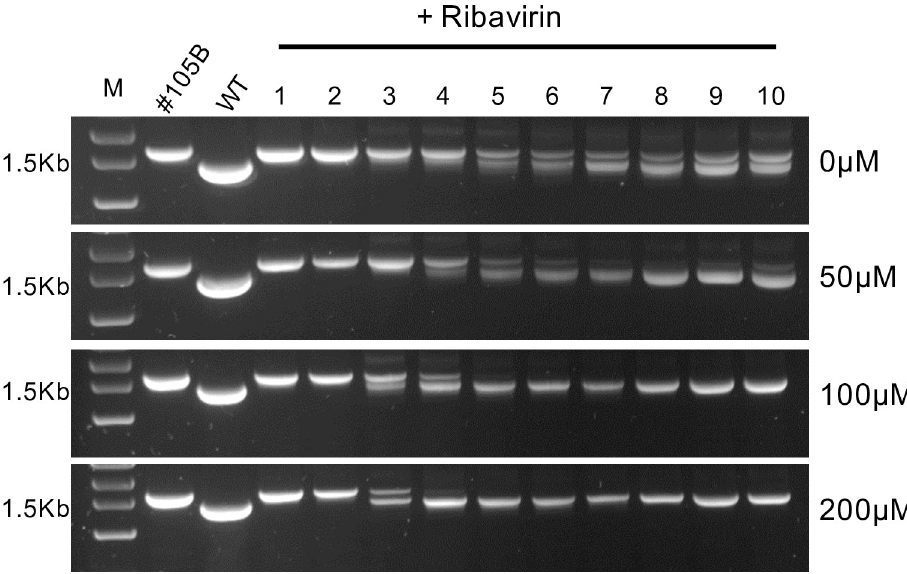
Fig 6. The rate of resolution of #105B increases in the presence of Ribavirin. #105B was serially passaged ten times on HeLa cells in the presence of 0, 50, 100 or 200 μ M of ribavirin. Viral RNA was extracted, amplified by PCR and analysed by gel electrophoresis. WT = PV3, representing genome-length product. M = GeneRuler 1kb plus DNA markers